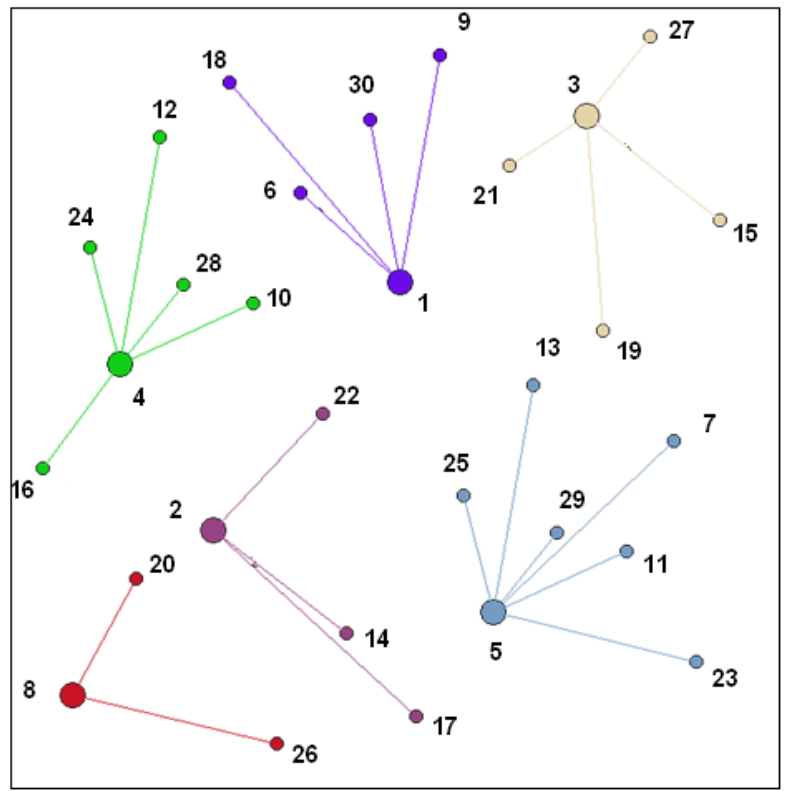
Figure 17. Clusters of a 30 node network formed after using the improved k-means clustering al- gorithm.